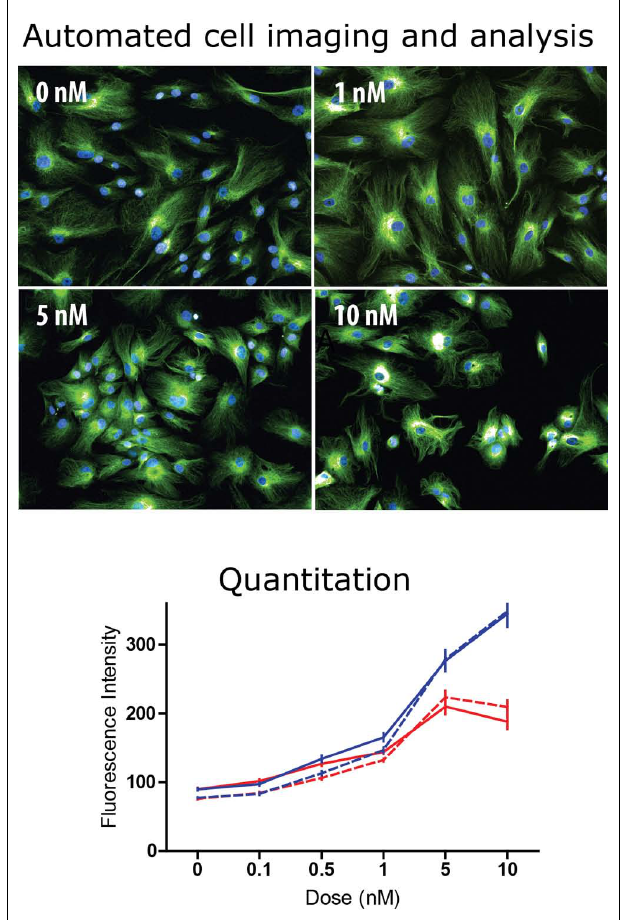
FIGURE 2 | High content screening: industrial scale microscopy. High content screening is the automated microscopic analysis of fluorescence in cells of a multiwell plate. Most high throughput screening assays read activity per well (e.g., fluorescence, absorbance, and luminescence). In high content screening fluorescence in individual cells is quantified with automated image analysis.Typically, algorithms find the cells in the image and then measure fluorescence intensity and spatial distribution.The example shows tubulin fluorescence in cells (green) and cell nuclei (blue) at different concentrations of taxol, a tubulin-binding drug.The drug effect is difficult to see by eye but the analysis algorithm identifies each cell and quantifies tubulin fluorescence intensity, plotted here as a dose–response curve to two drugs, taxol (blue) and vinblastine (red) in two cell types: control-derived ONS cells (solid lines) and HSP patient-derived ONS cells (dashed lines; Abrahamsen etal., 2013).With high content screening thousands of cells can be analyzed to reveal small but significant differences between drugs, doses, and cell